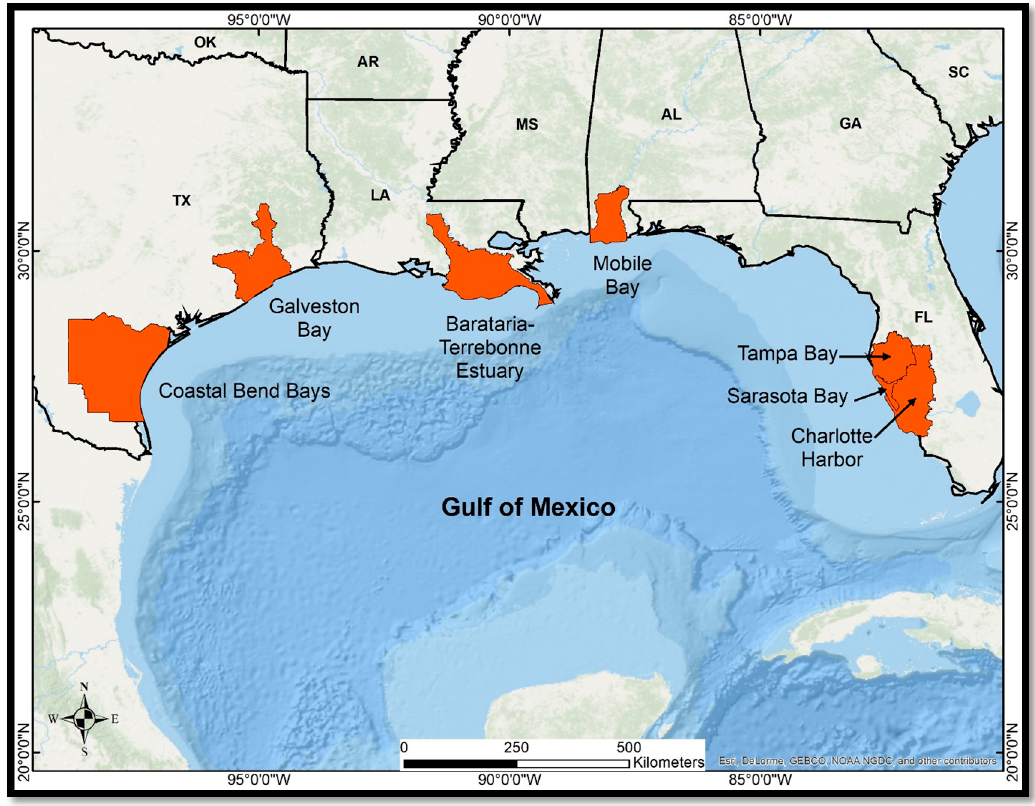
Figure 1. Environmental Protection Agency National Estuary Programs of the Gulf of Mexico studied here.